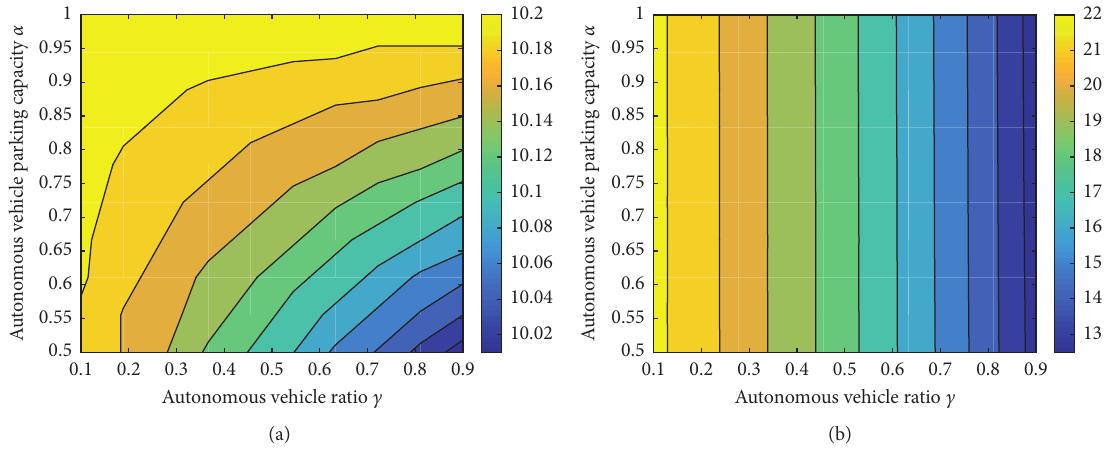
Figure 12: (a) Equilibrium cost of autonomous vehicles and (b) equilibrium cost of conventional